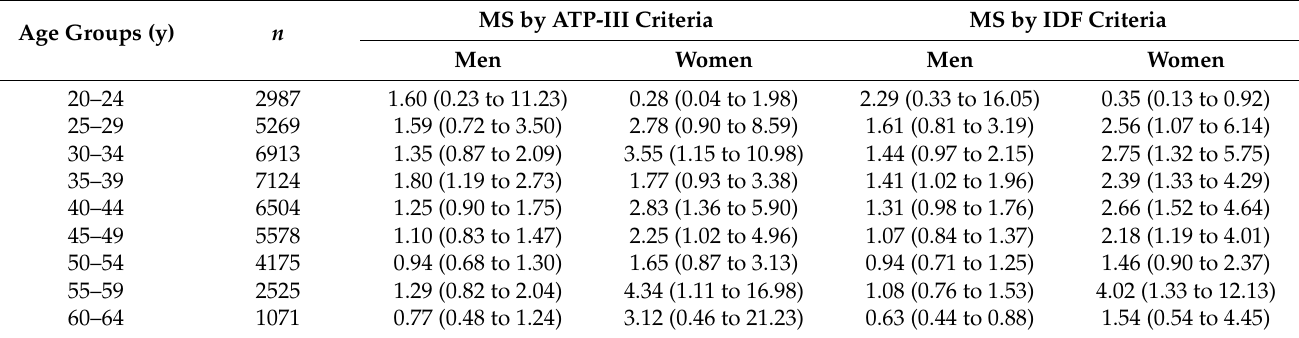
Figure 1. Across all ages, men presented higher BMI values than women. In men, BMI increased with age and was generally higher in social class III than in the other two classes. Women’s BMI was consistently higher in social class III than in the other two classes for all age